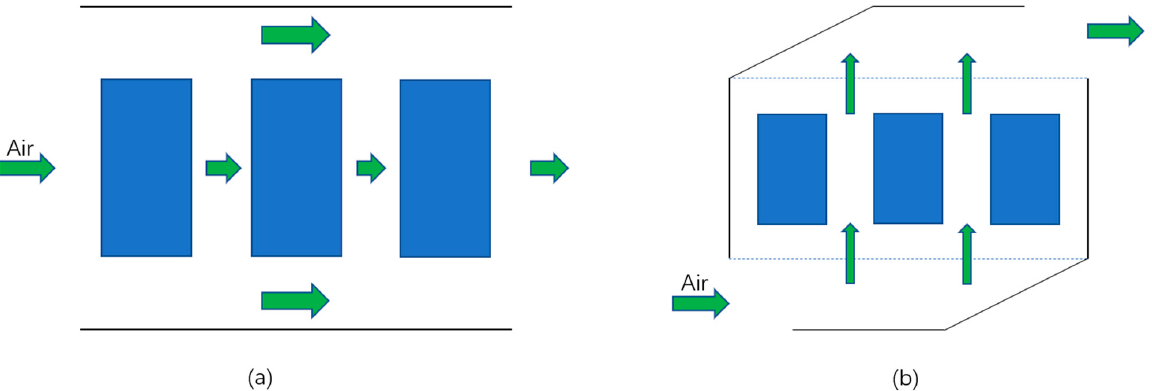
Figure 2. The schematic diagram of the air supply mode of the air-cooling system, ( a ) the serial air supply, ( b ) the parallel air supply.